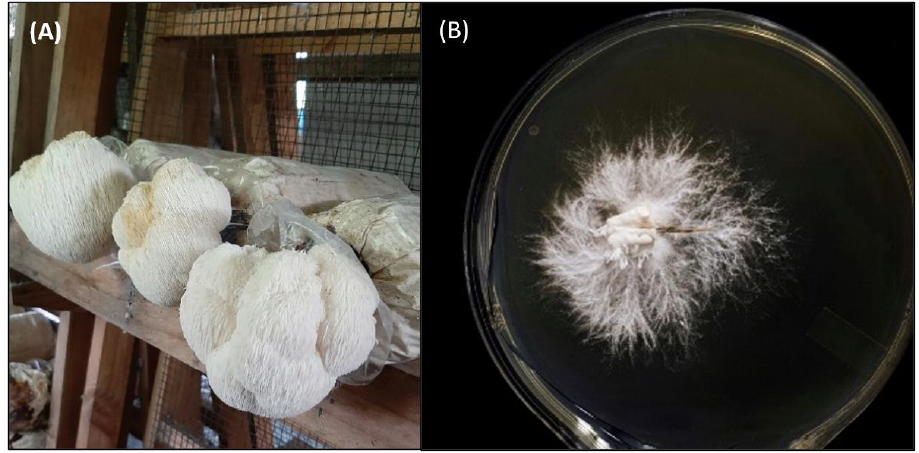
Figure 1. Hericium erinaceus fruiting body ( A ) and mycelia ( B ). The structural characterization and isolation of compounds in the polysaccharide fraction (mainly beta-glucans) and secondary metabolites (e.g., hericenones, erinacines, hericerins, resor- cinols, monoterpenes, diterpenes, steroids, and volatile aromatic compounds) of HE fruiting bodies and mycelia have been shown to have immune-modulatory activities, neurogenesis, antioxidative, anti-inflammatory, and anti-cancer properties [17,19,20,23]. These neurotrophic compounds have potential as treatments for AD, due to their potential to penetrate through the blood–brain barrier [26]. Additionally, recent studies have reported that HE can modu- late neural activity, such as increasing synaptic plasticity, reducing apoptosis, decreasing A β plaques, and inhibiting acetylcholinesterase (AChE) and BACE1 [27], supporting its therapeutic potential in the management of AD. This narrative review discusses recent clinical and animal studies on the therapeutic efficacy of HE for